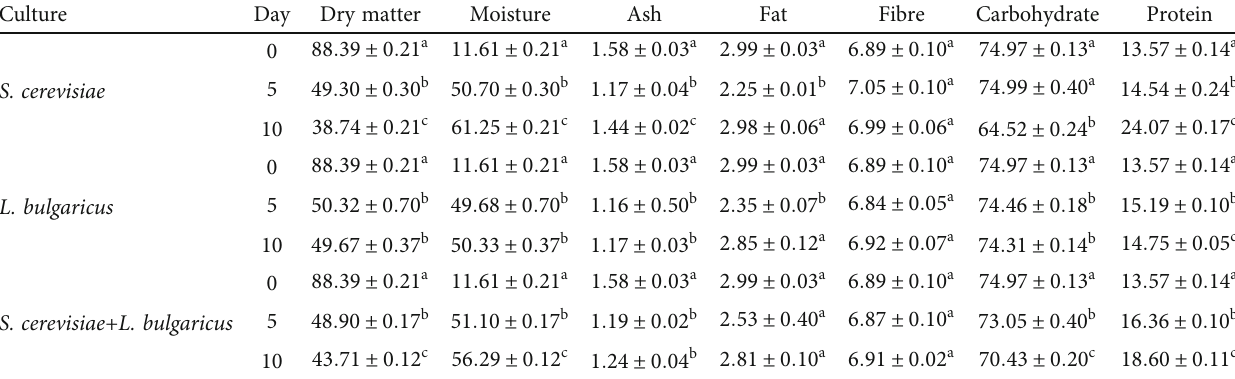
Table 5: Changes in the chemical composition of fermented, formulated blends of unmalted and malted sorghum in a ratio of 1 :3 ( w / w ) with monocultures of S . cerevisiae or L . bulgaricus and a coculture of S . cerevisiae and L . bulgaricus (data presented are based on the dry matter). a – c Means within a column with di ff erent superscripts are signi fi cantly di ff erent ( p ≤ 0 : 05 ). Results expressed as mean ð n = 3 Þ ± SD (standard